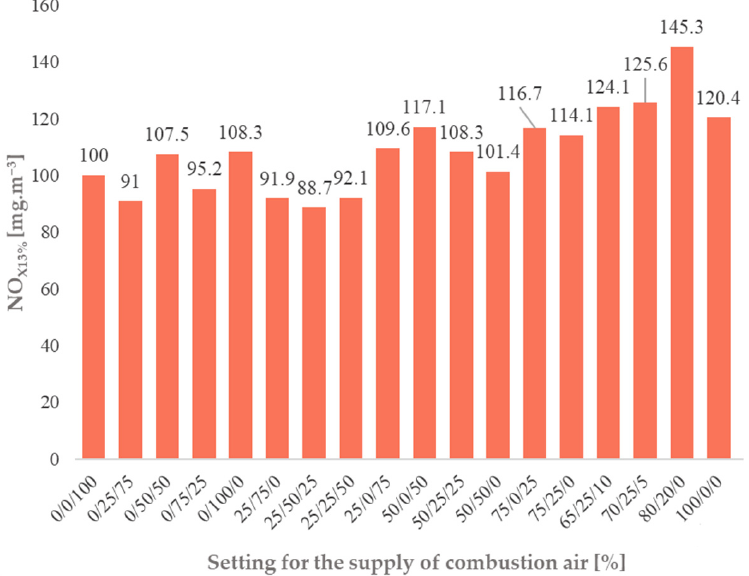
Figure 6. The formation of nitrogen oxides during different settings for air supply.